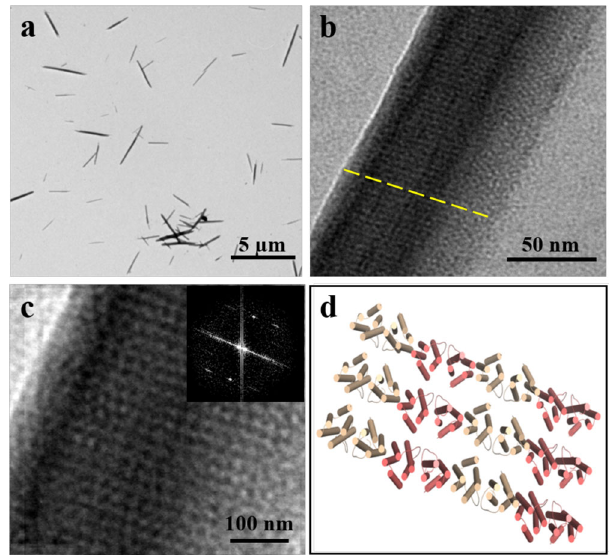
Fig. 4 TEM analyses of the nanorods constructed by 12.0 µ M FLAL and 30% PEG1500. a Low-magni fi cation TEM view of the formed nanorods. b High-magni fi cation view of a . The yellow dotted line indicated the assembled direction of FLAL molecules. c Real map of the inverted FFT from b . Inset: Fast Fourier transform image. d Structural diagram based on the reconstruction of c .